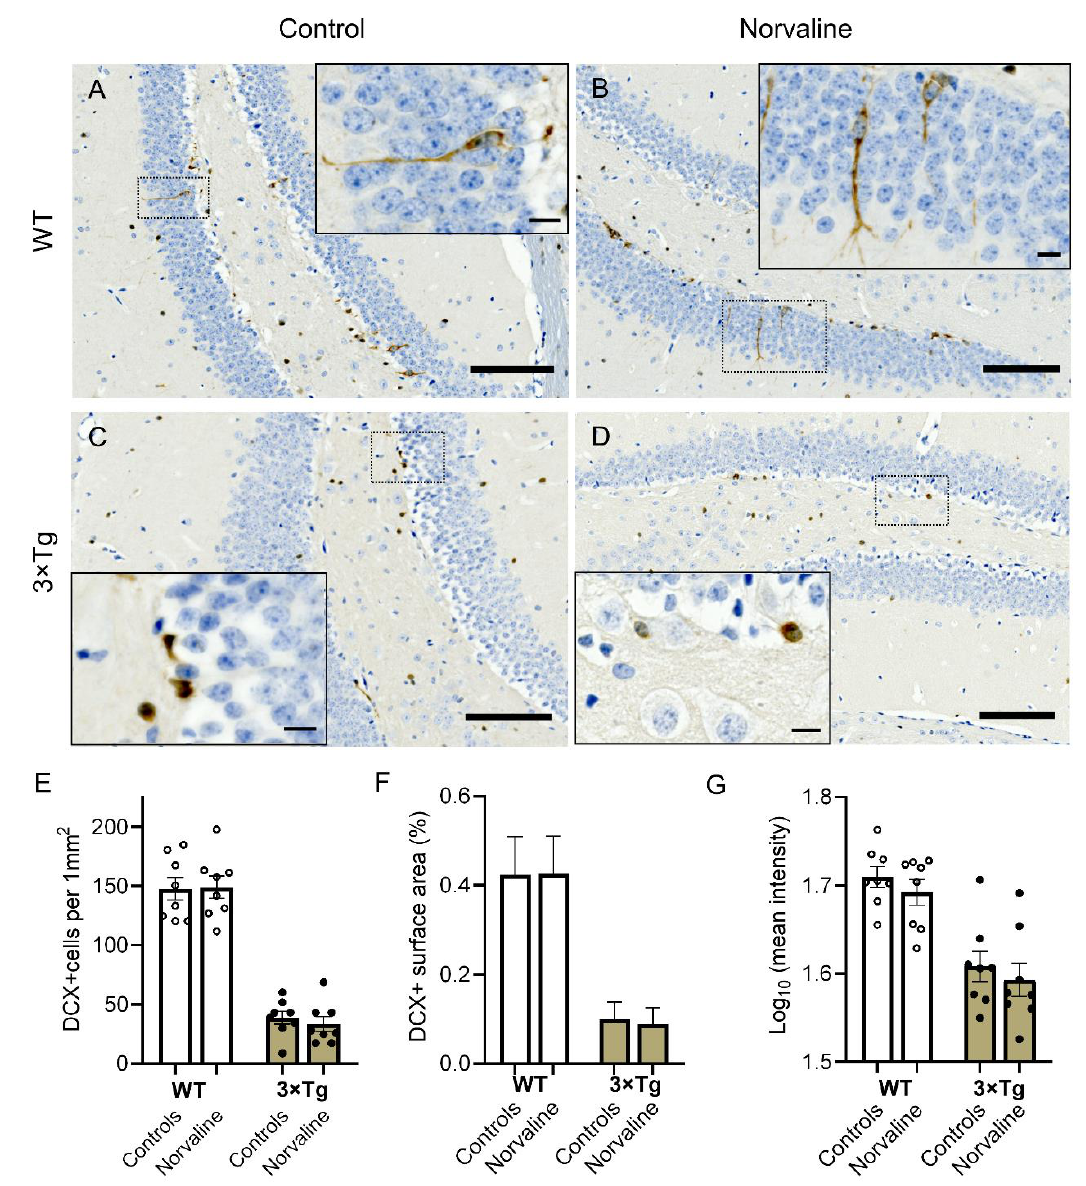
Figure 1. Representative × 40 bright-field micrographs showing the distribution of newly generated doublecortin-positive (DCX + ) cells in the dentate gyrus of 7-month-old male wild-type (WT) ( A , B ) and 3 × Tg ( C , D ) mice in relation to norvaline treatment. Scale bars represent 100 µ m. Brain sections were counterstained with hematoxylin. Newborn cells (brown reaction product) are present in both blades of the dentate gyrus and the hilus area. Insets ( A , B ) with × 100 magnified views show DCX + neurons somata in the inner third of the granule cell layer. The cells possess bipolar shape and demonstrate dendritic growth into the outer dentate molecular layer. Insets ( C , D ) show spherical-shaped and processes-deficient DCX + neurons clustering in the SGZ. Scale bars indicate 10 µ m. ( E ) DCX + cell density. ( F ) DCX immunopositive surface area. ( G ) DCX stain intensity. The data are presented as means ± SEM, n = 8.